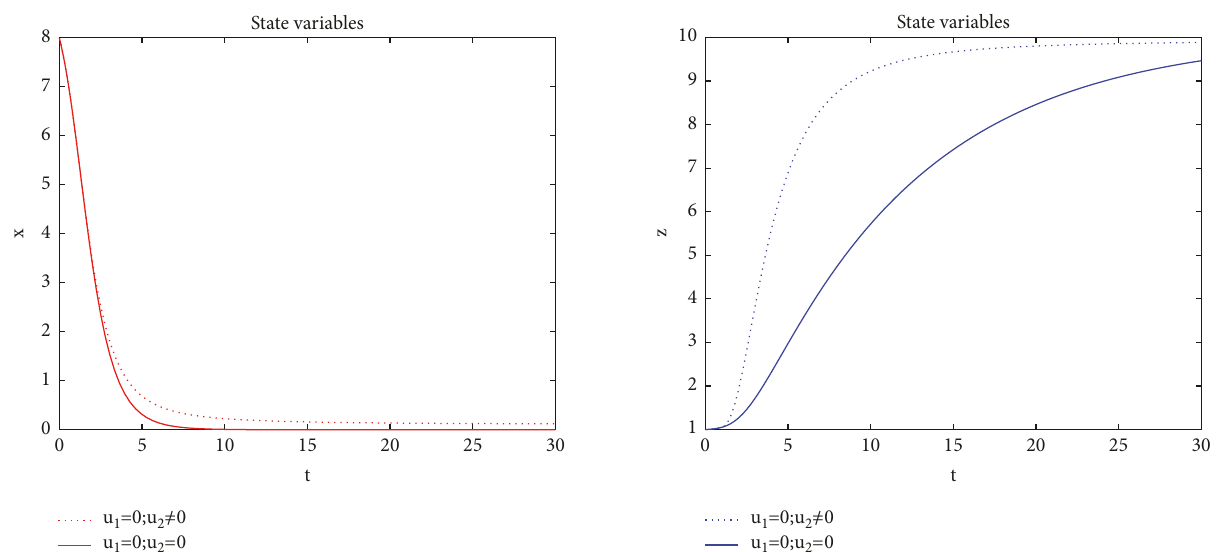
Figure 7: Evolution of number of 𝑧(𝑡) with or without control.